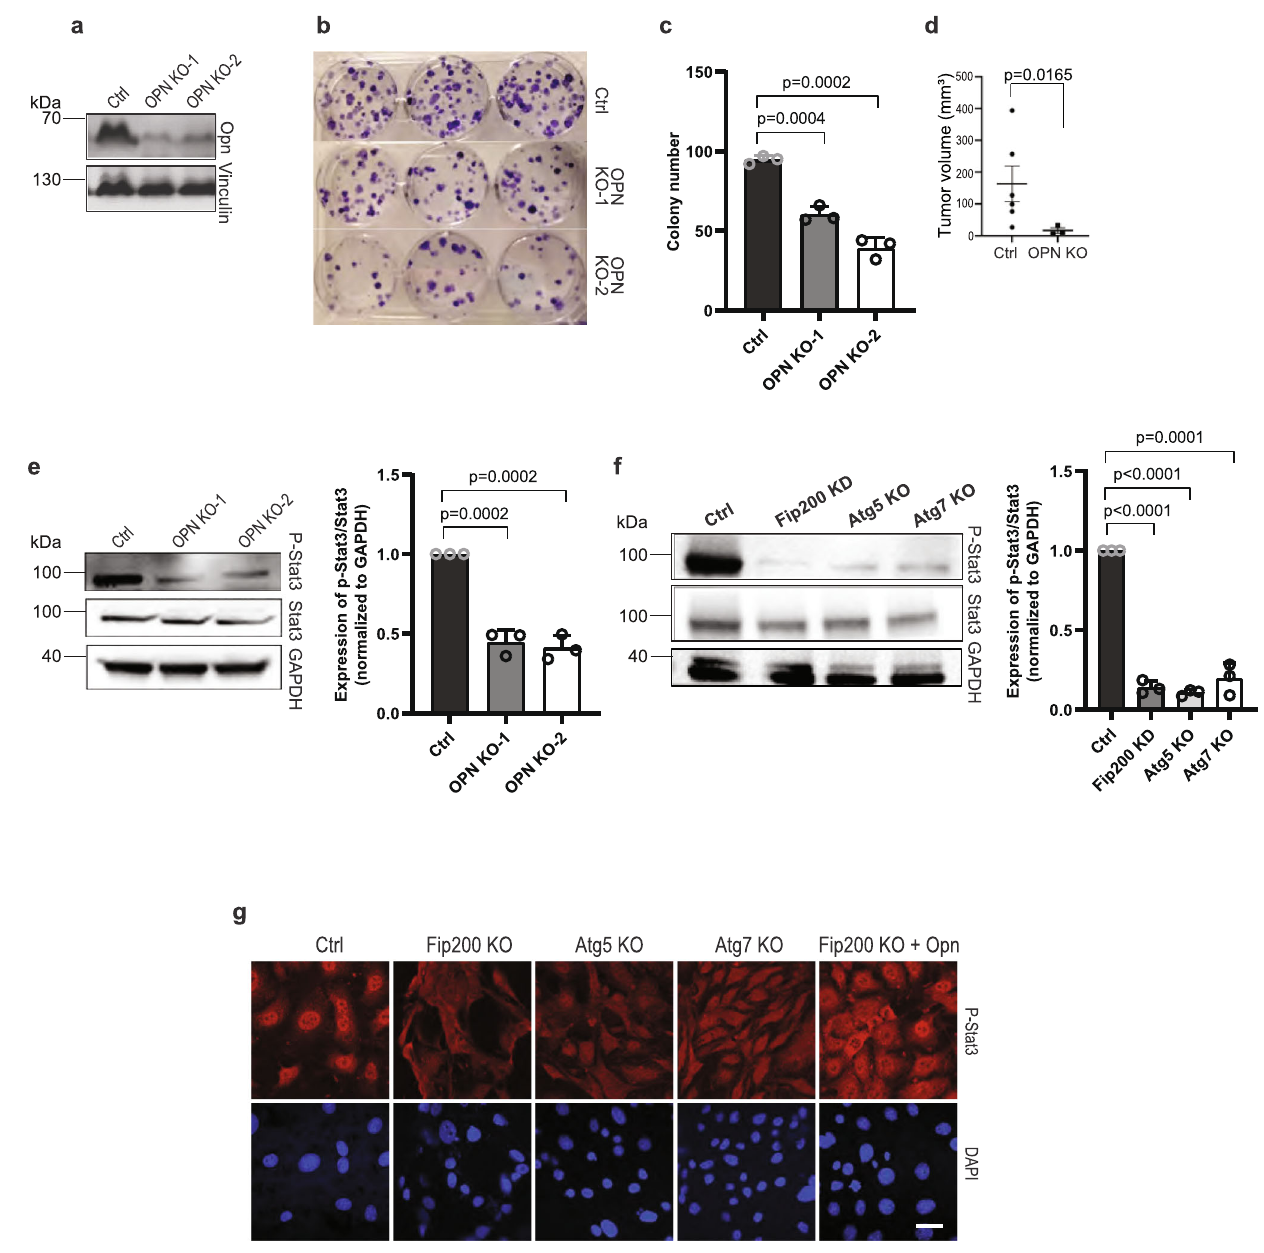
Fig. 5 | OPN knockout inhibits vascular tumour cell colony formation, tumor- igenicity and Stat3 phosphorylation. a Lysates from Ctrl and two clones of OPN KO tumour cells were examined by western blots for OPN and Vinculin. b , c Representative images of colony formation assay of Ctrl and OPN KO tumour cells are shown in b , and mean±SD of the colony number are shown in c . n =3 biologically independent cells. d Ctrl and OPN KO tumour cells were sub- cutaneously injected in recipient nude mice. Mean±SEM of tumour volume at 10weeksafterinjectionisshown. n =3miceforeachgroup. e LysatesfromCtrland OPN KO tumour cells were examined by western blots for P-Stat3, Stat3 and GAPDH. Relative levels of pSTAT3/STAT3 (normalized to Ctrl cells) are shown as